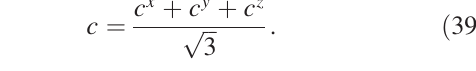
ffiffiffi p 3 =a ¼ × 4 ≈ 7 ; the circ in Eq. (6) and W in Eq. (10)] being unity. v p